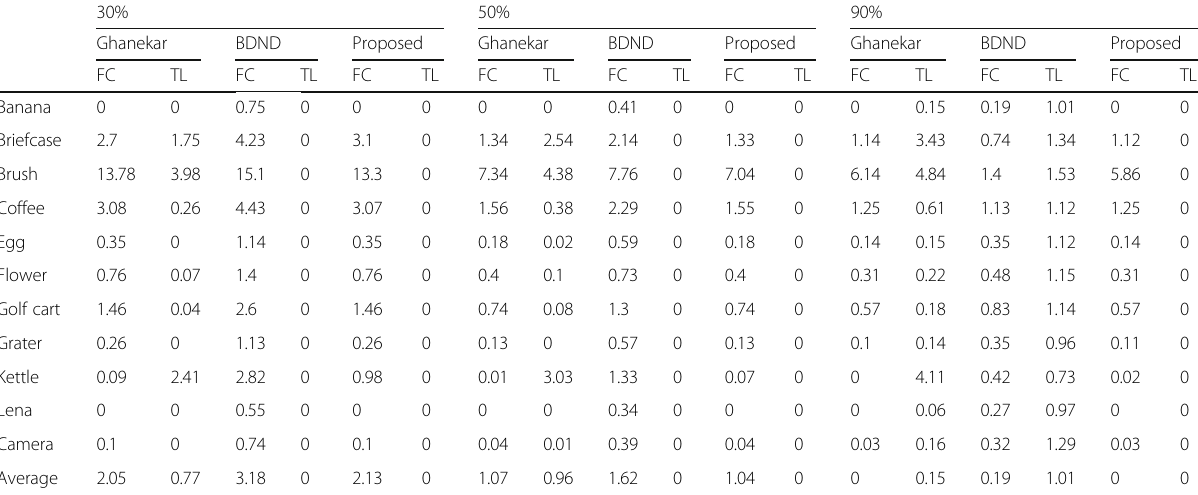
Table 1 False caught (FC) and true left (TL) comparison